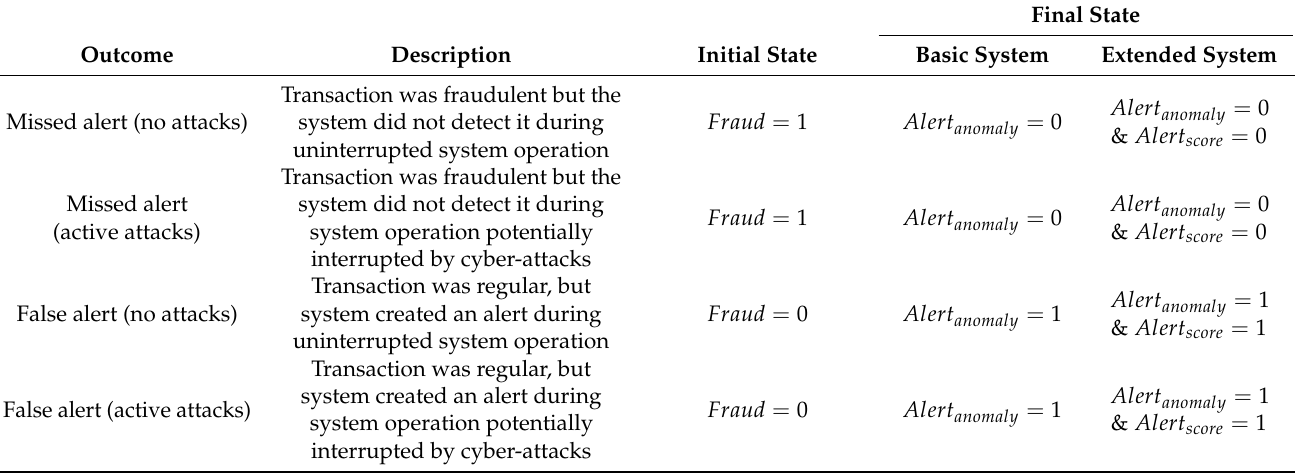
Table 5. Possible outcomes of the modelled